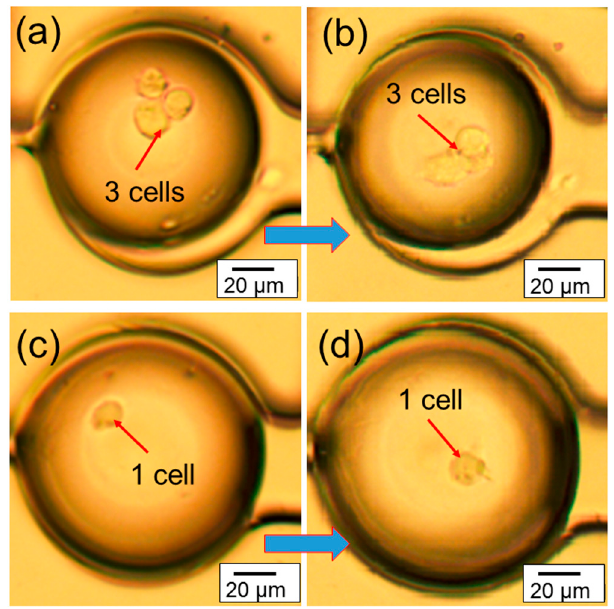
Figure 4. Representative optical images showing ( a , b ) the migration of three cells inside 3D microtissue during a 7 h period at 37 °C; ( c , d ) the migration of one cell inside 3D microtissue during a 7 h period at 37 °C.